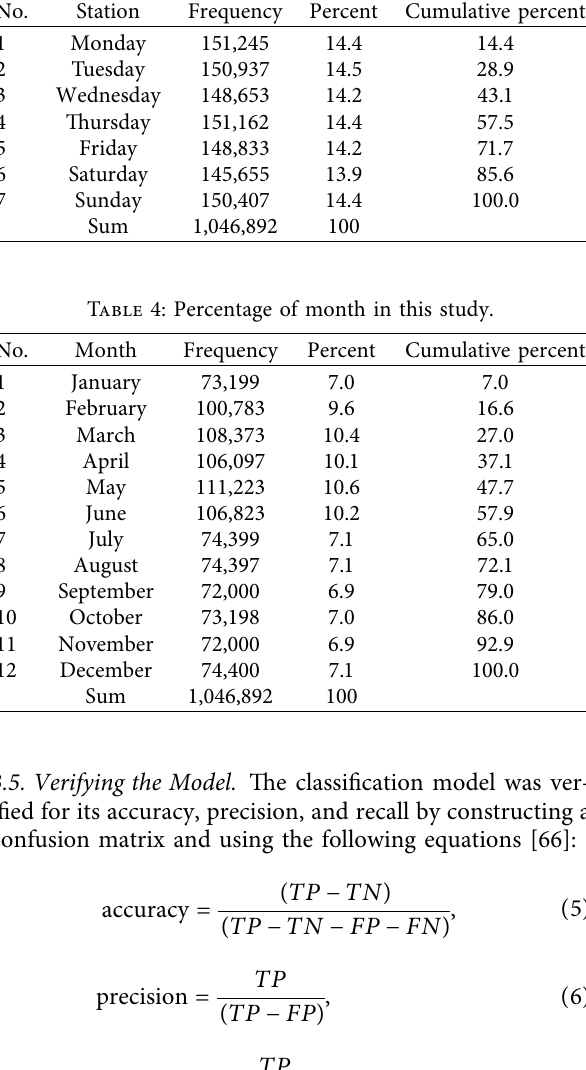
Table 3: Percentage of day of a week in this study.